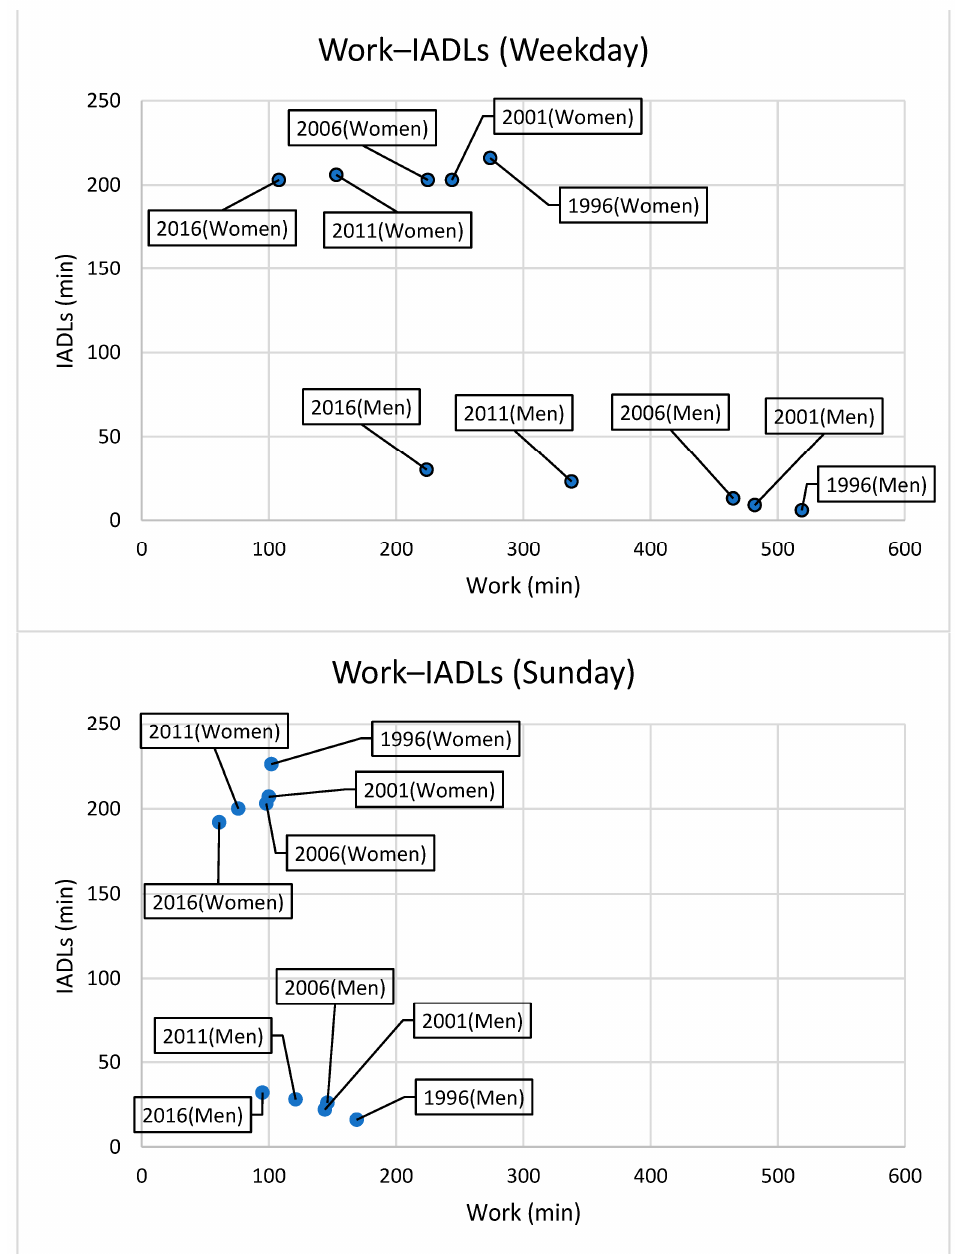
Figure 3. Temporal correlation between work and IADLs (weekdays, Sunday).